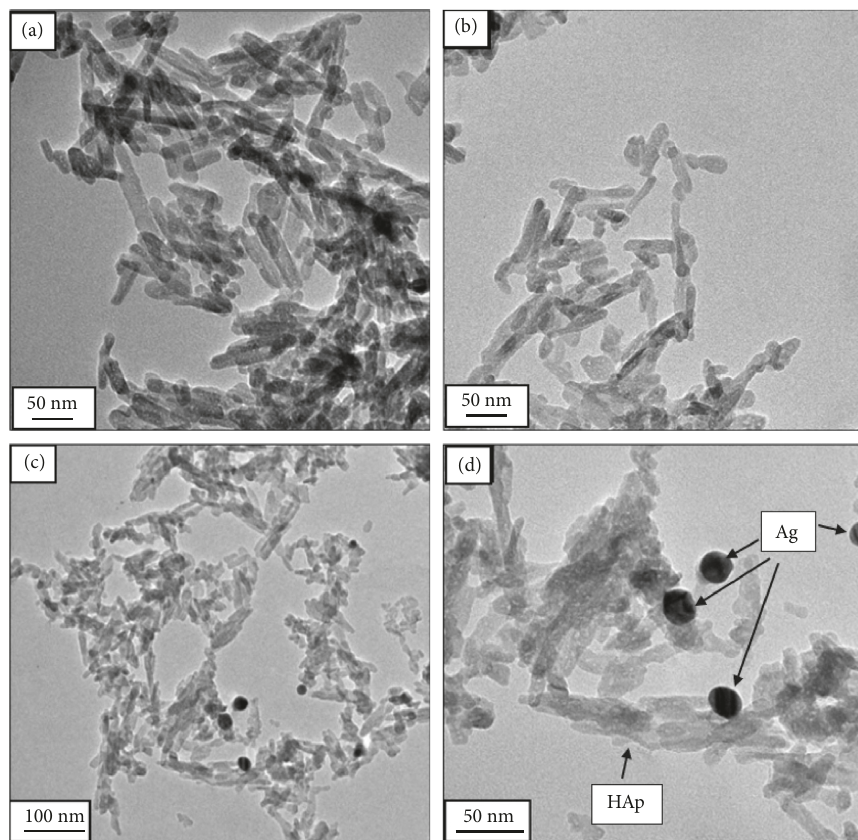
Figure 7: TEM micrographs of sonosynthesized HAp (a, b) and Ag-HAp (c,